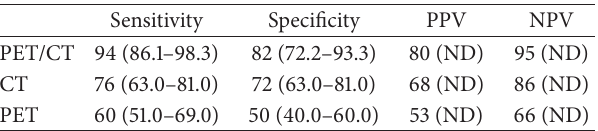
Table 5: Patient-based analysis of diagnostic accuracy of PET/CT, CT, and PET ( 𝑛 = 103